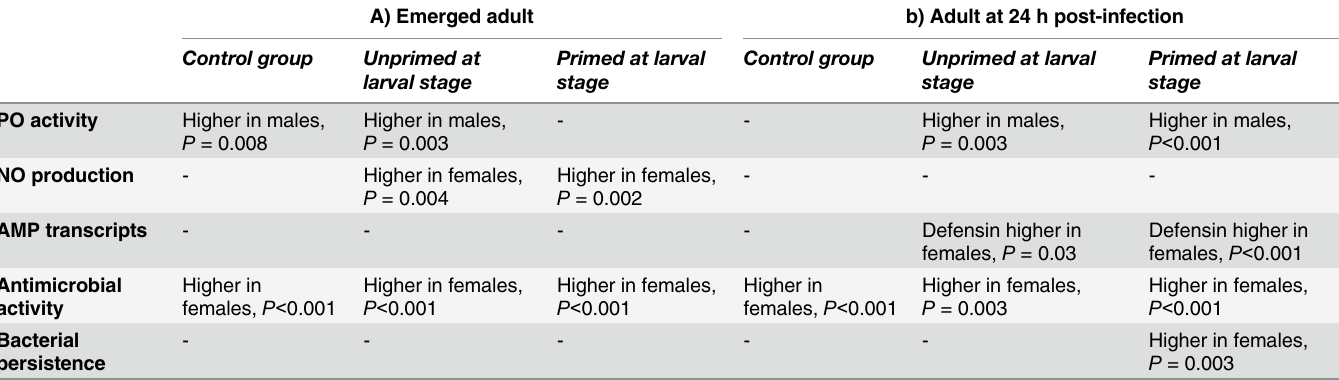
Table 2. Gender-based immune differences among: a) emerged adults, and b) adults at 24 h post-infection.